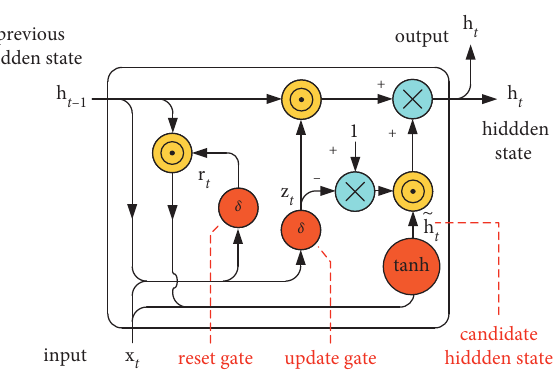
Figure 1: Cell of gated recurrent